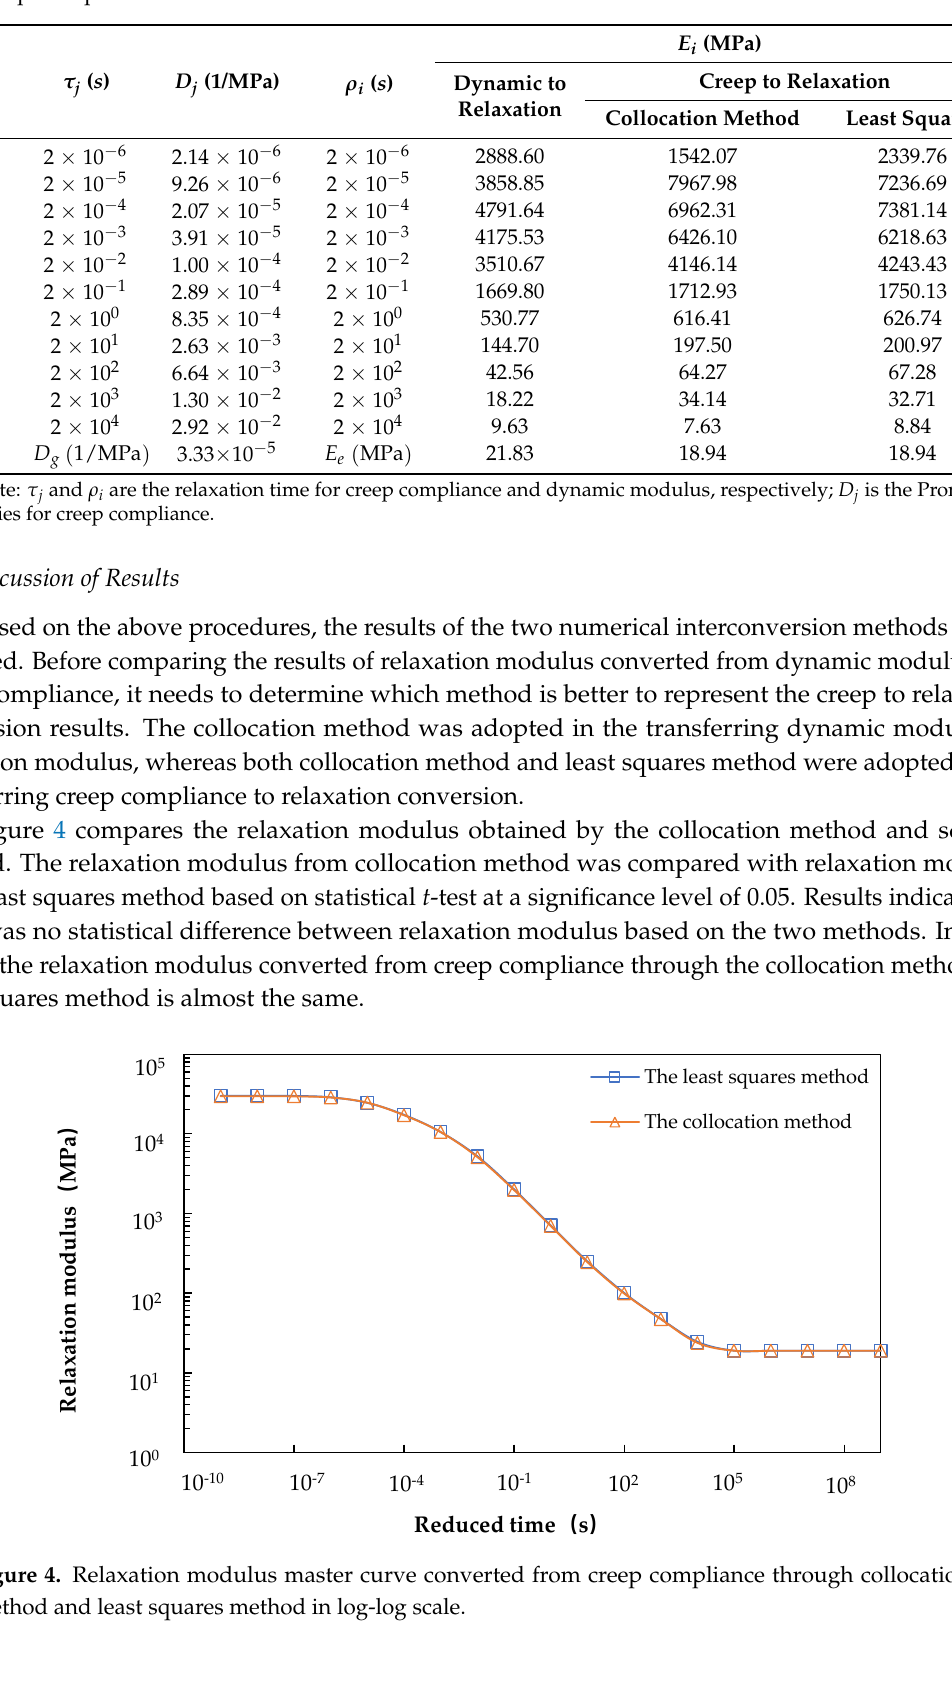
Table 3. Prony Series Coefficients of Relaxation Modulus Obtained from Dynamic Modulus and Creep Compliance.